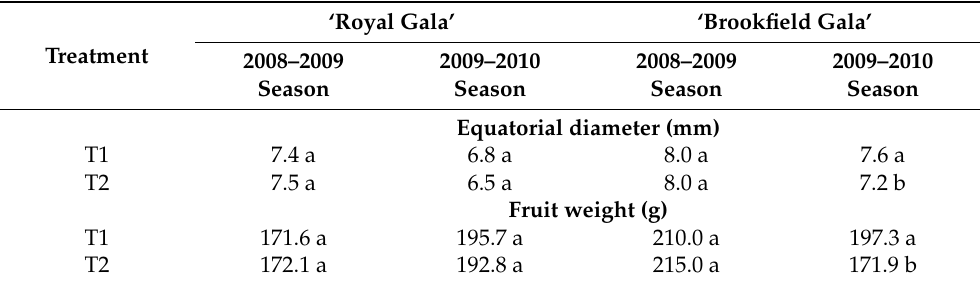
Table 6. Fruit quality in ‘Royal Gala’ and ‘Brookfield Gala’ apple trees at harvest for two water application treatments during the 2008–2009 and 2009–2010 seasons. ‘Royal Gala’ ‘Brookfield Treatment